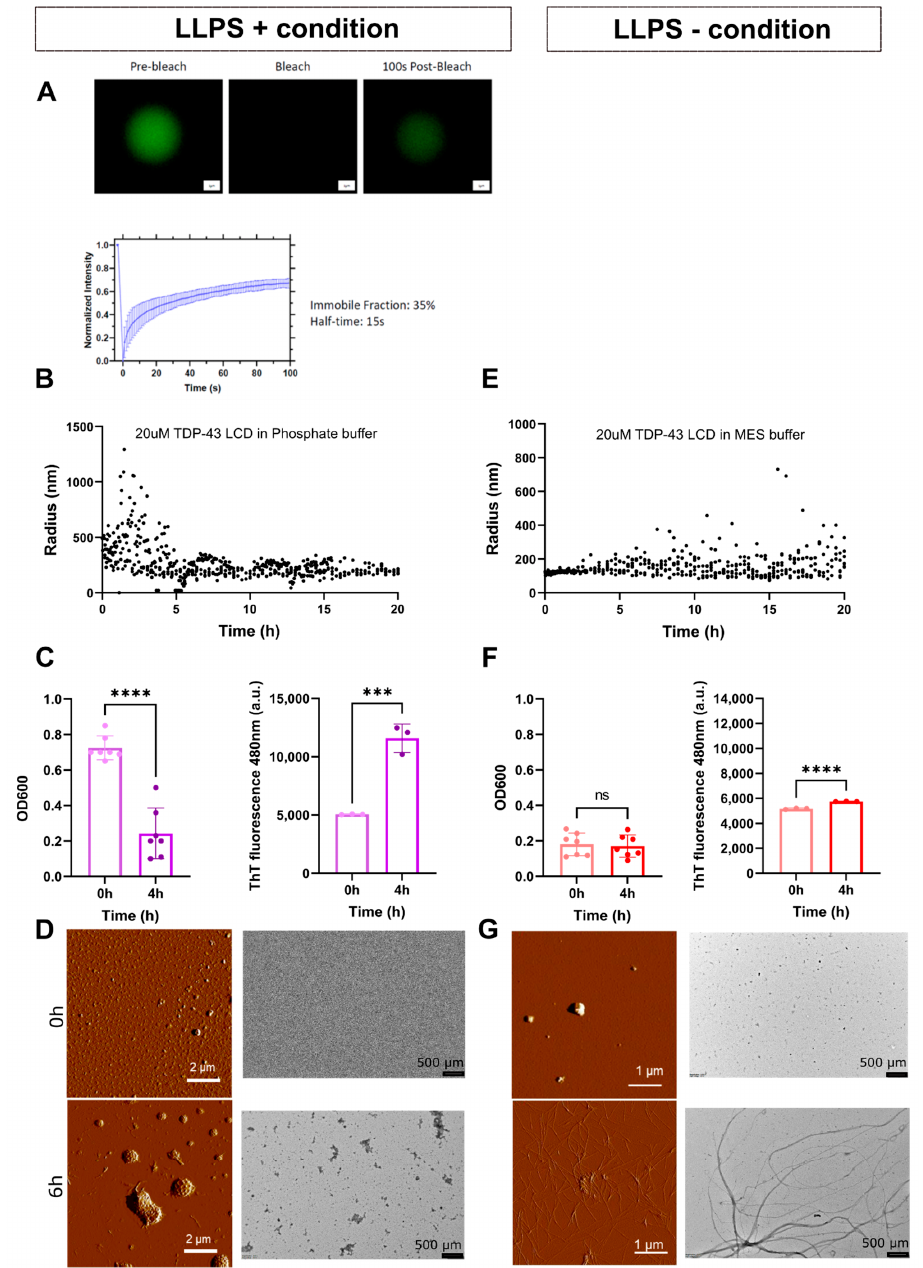
Figure 1. Characterization of the TDP-43 LCD behavior in phosphate buffer (LLPS+) and in MES buffer (LLPS-). ( A ) Fluorescence recovery after photobleaching (FRAP) of labeled TDP-43 LCD (20 µ M) showing droplet recovery in the LLPS+ condition (50 mM phosphate buffer, pH 7.5) for three individual experiments. FRAP was not possible for the LLPS- condition (20 mM MES buffer, pH 5.5) as there were no droplets present. Examples of the droplets at different time points are shown on top of the panel. Scale bar = 1 µ m. ( B ) Average of triplicate dynamic light scattering (DLS) data showing radius of protein within a 20 h time frame. Maximum size of droplets in LLPS+ buffer was 1.3 µ m. ( C ) Turbidity (OD600) and fluorescence (ThT) values at time 0 h and 4 h. Statistical differences determined with an unpaired Student’s t -test with n = 3 for ThT graphs to look at aggregation and n = 7 for OD600 to look at LLPS absorbance at time 0. Data are presented as mean ± SD, **** p < 0.0001, *** p < 0.001. ( D ) Atomic force microscopy (AFM) and electron microscopy (EM) of TDP-43 LCD at 0 h and 6 h. ( E ) DLS data of TDP-43 LCD in MES buffer without LLPS. ( F ) Turbidity and absorbance of TDP-43 LCD in MES buffer at 0 h and at 4 h. Statistical differences determined with an unpaired Student’s t -test; **** p < 0.0001. ThT n = 3 and OD600 n = 7, mean ± SD is shown. ( G ) Atomic force microscopy and electron microscopy of TDP-43 LCD at 0 h and 6 h. Scale bar length is indicated on each